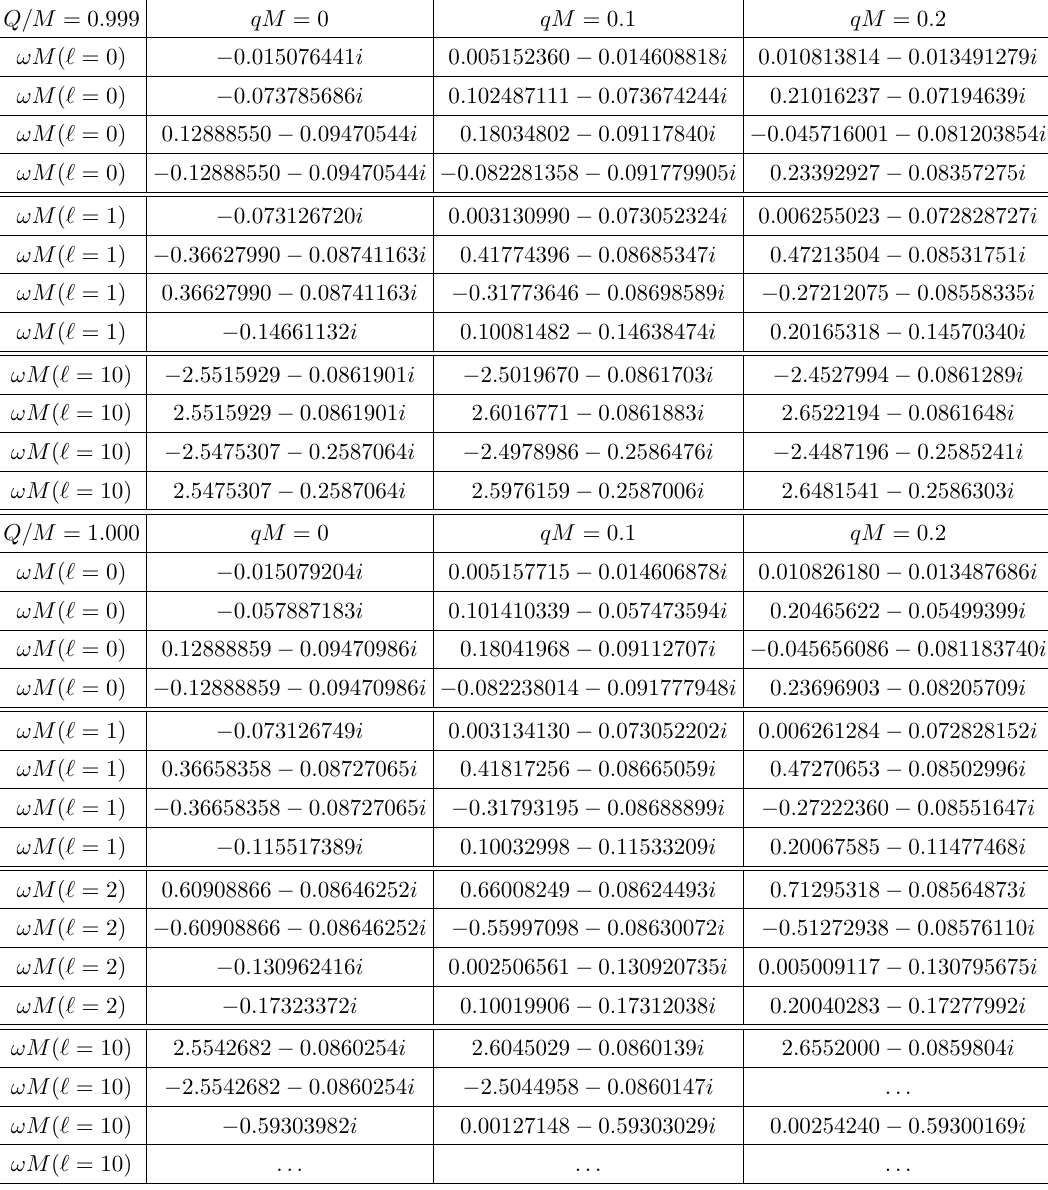
Table 13 . The QNFs ωM for massive ( mM = 0 . 05 ) scalar fields in the background of RNdS black holes with Λ M 2 = 0 . 01 , and different values of ‘ , and qM . Here, for Q/M = 0 . 999 , ∆ r/M ≈ 0 . 148 , and for Q/M = 1 , ∆ r/M ≈ 0 . 118 , with ∆ r/M = ( r H − r C ) /M . For Q/M = 1 . 002 two complex roots appear for f ( r ) . “. . . “ means that it is not possible to guarantee the convergence of the QNFs with 270 Chebyshev